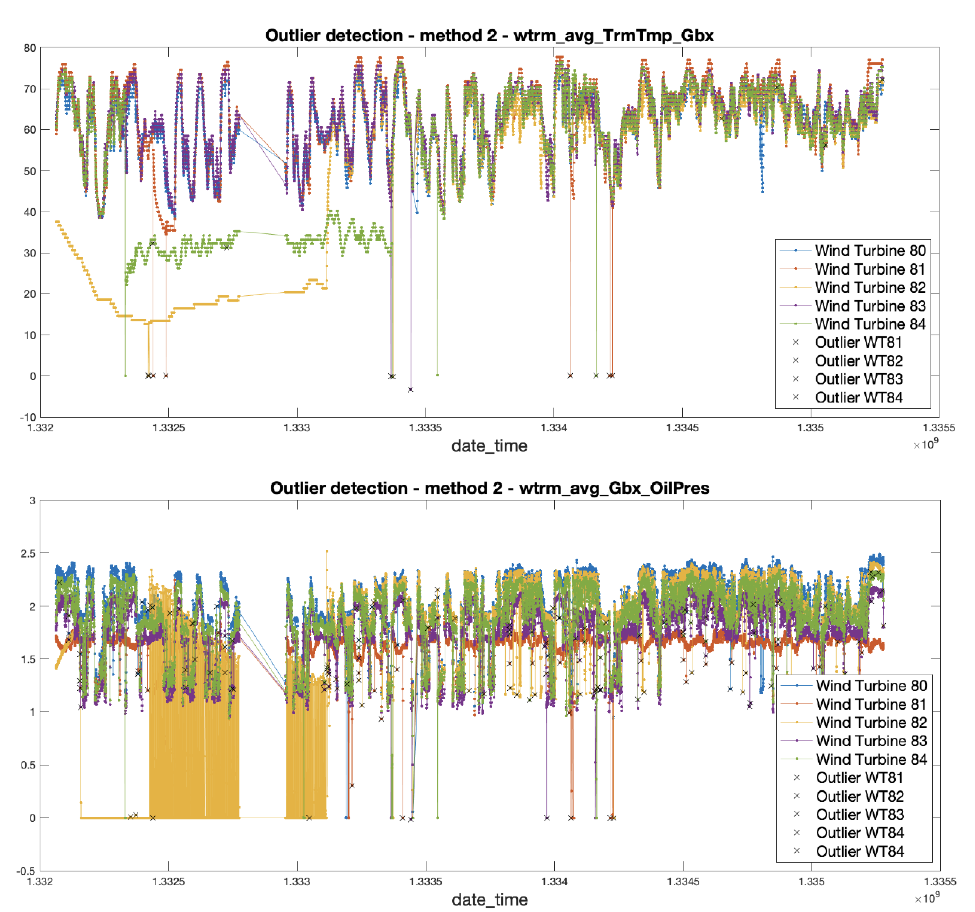
Figure 5. Plot of a fragment of the signals wtrm_avg_TrmTmp_Gbx at the top and wtrm_avg_Gbx_OilPress at the bottom corresponding to the Gerabox subsystem prior to the fil- tering of outliers. It can be observed that in some periods of the graphs, the variables of WT81 and WT84 are not in line with the general operation.